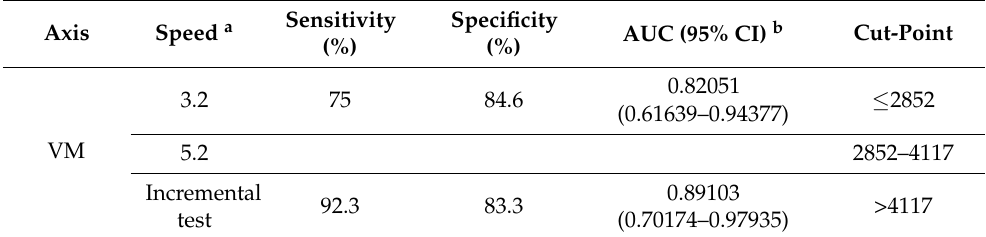
Table 1. Generated cut-points per walking speed